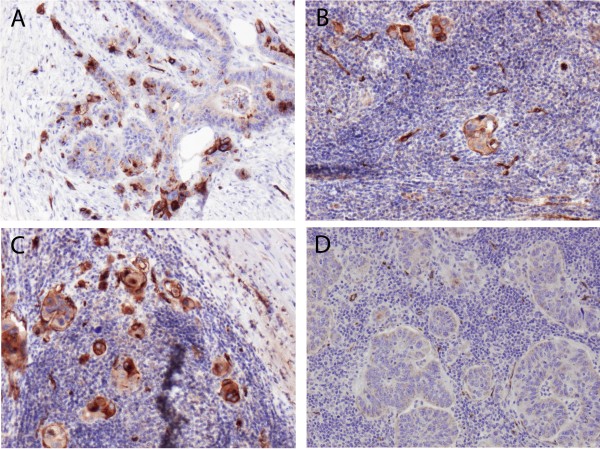
Immunohistochemical sample images from one case with positive membranous PODXL staining in the primary tumour (A), and corresponding positive (B,C) and negative (D) lymph node metastases.